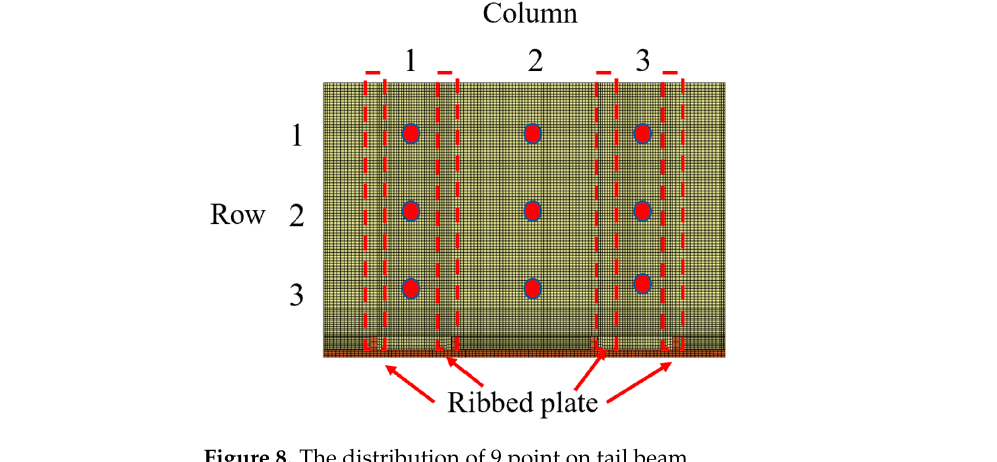
Figure 8. The distribution of 9 point on tail beam.